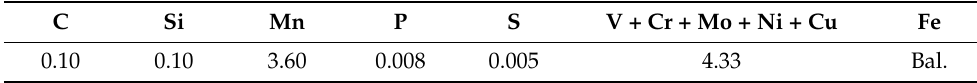
Table 1. Chemical composition of experimental steel.